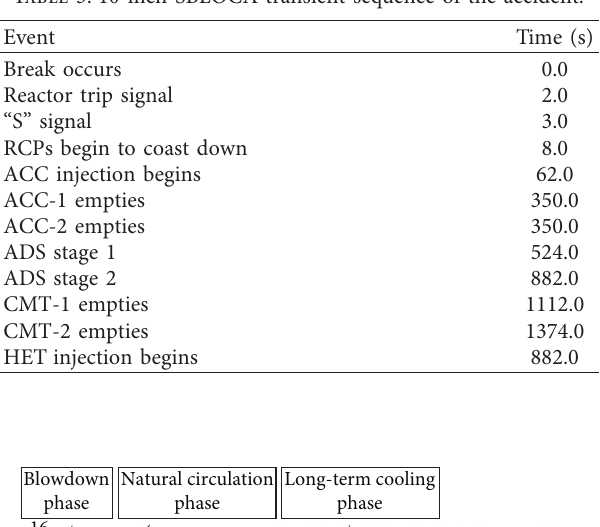
Table 3: 10-inch SBLOCA transient sequence of the